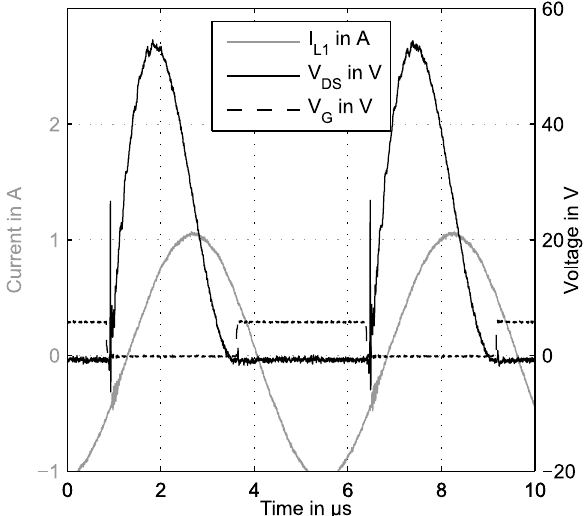
Figure 7. Some measured signals. Notice that the amplifier is well tuned. The output power is approx. 9 W.